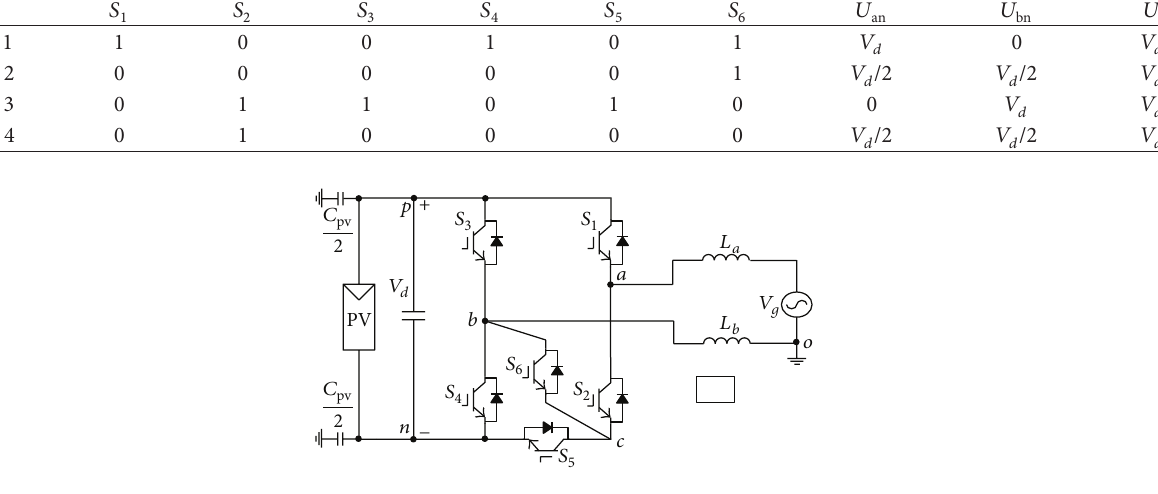
Figure 1: Schematic diagram of proposed power electronic inverter circuit.